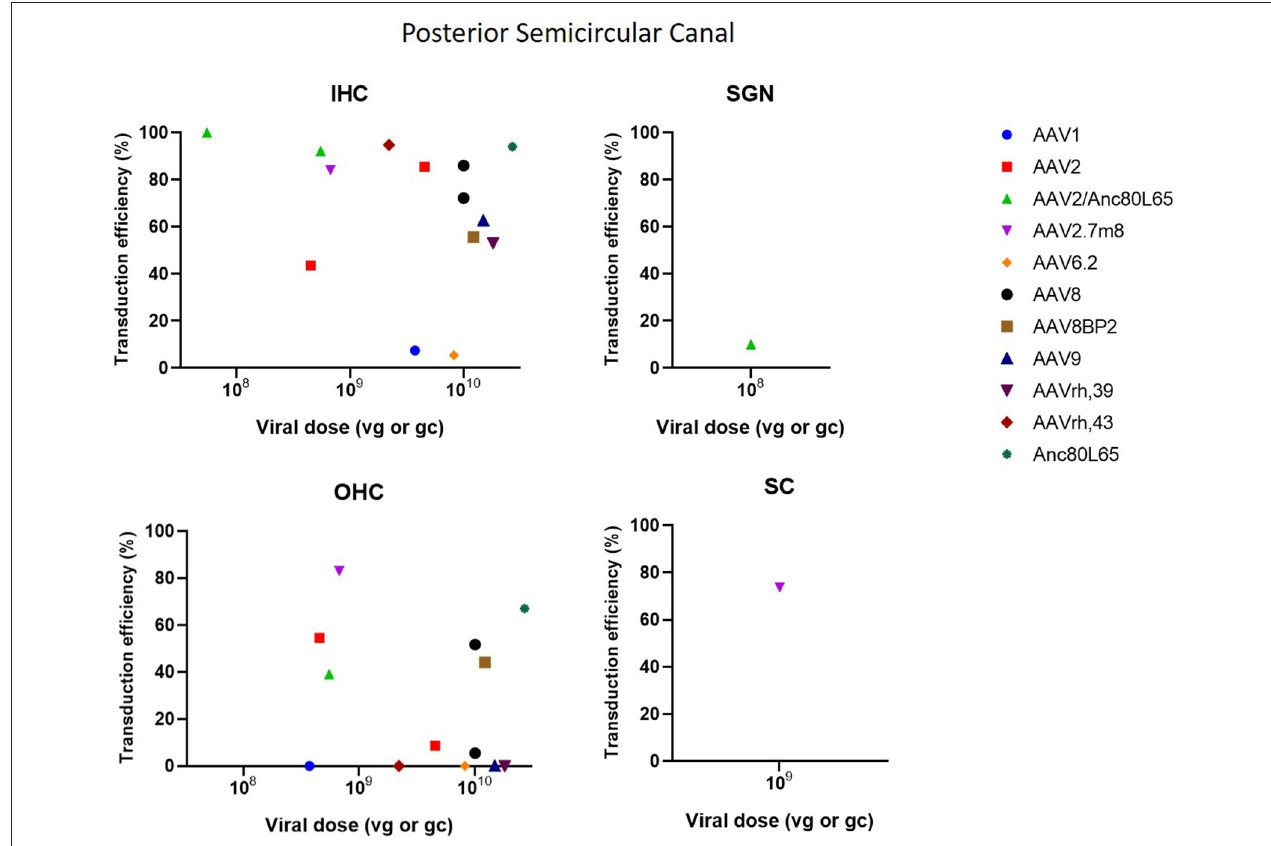
FIGURE 5 | Transduction efficiency of IHC, OHC, SGN and SC according to viral vector dose using the posterior semicircular canal injection. Only data from studies that performed inner ear application of AAV in mice were used to plot these graphs. IHC, inner hair cell; OHC, outer hair cell; SGN, spiral ganglion neuron; SC, supporting cell in organ of Corti; AAV, adeno-associated vector; gc, genome copies; vg, viral